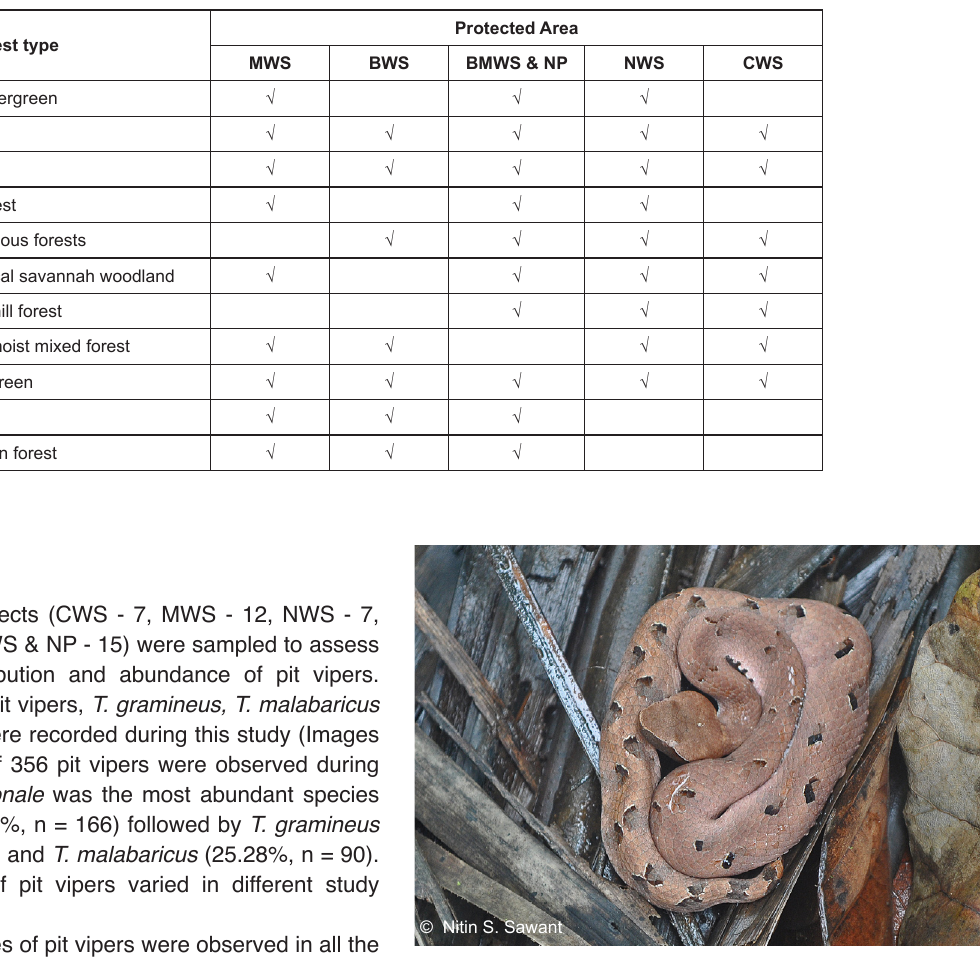
Table 1. List of forest types present in the study